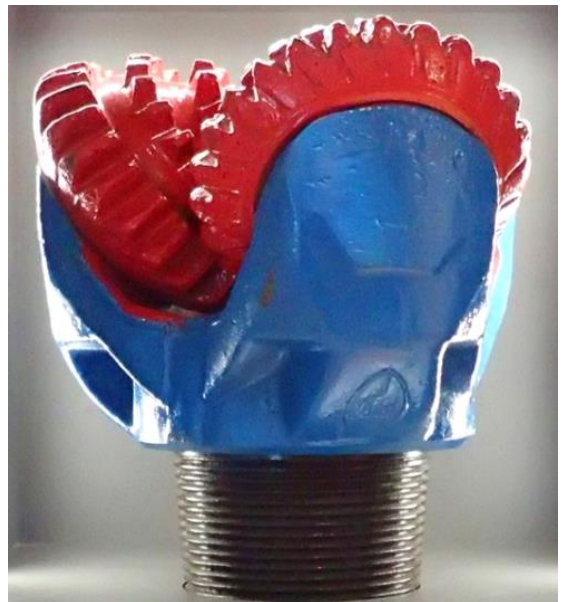
Figure 5. The drilling bit of a mining machine used to drill boreholes for the extraction of groundwater in Bad Buchau in the form of an exhibit in the entrance hall of the health resort complex